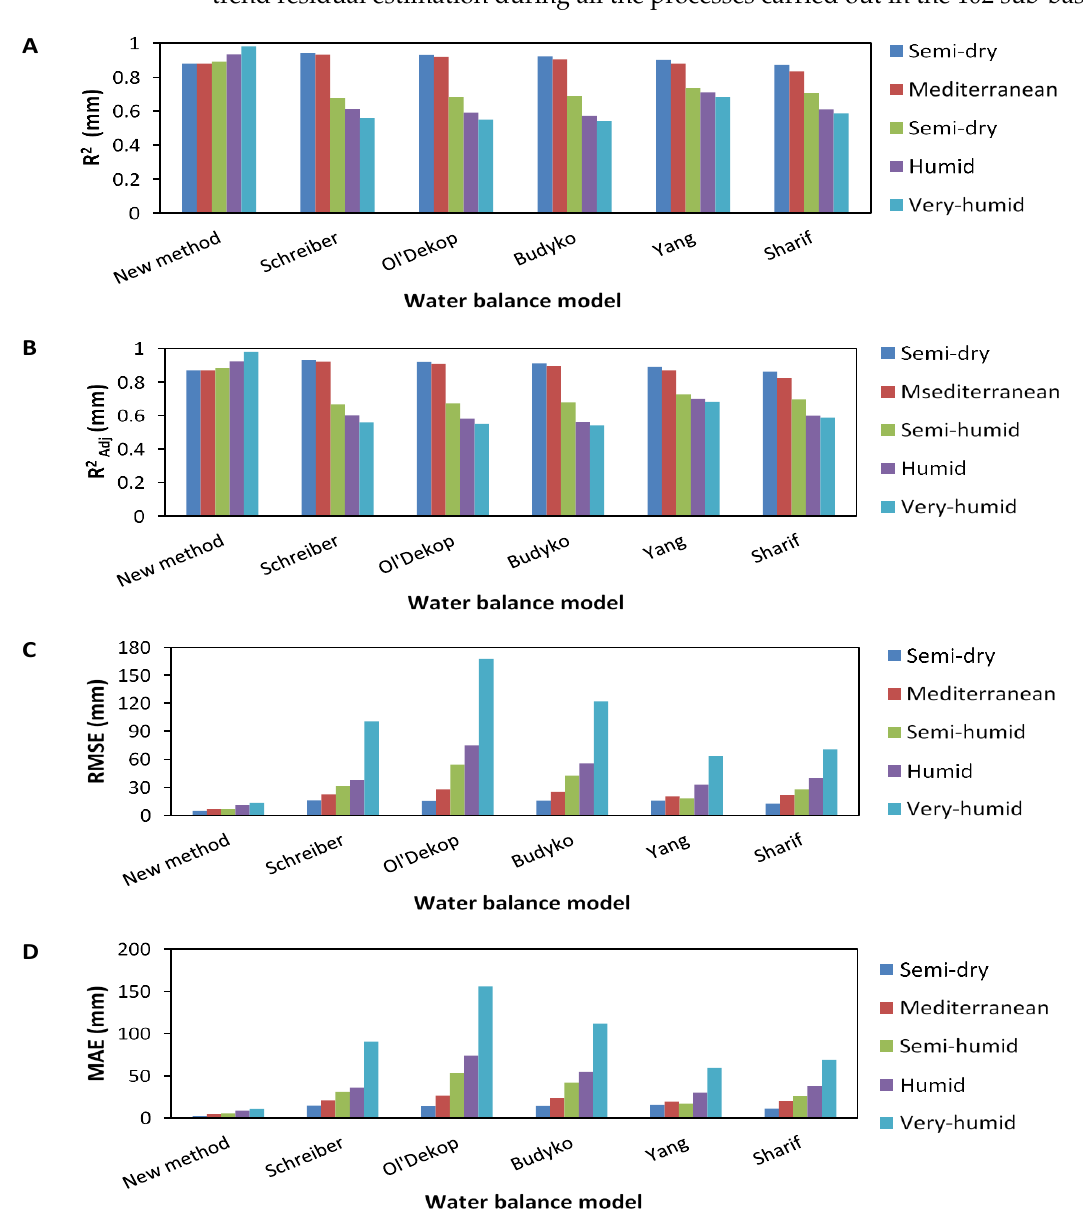
Figure 10. Histograms explaining performance analysis of the new model against a set of parametric (Yang, and Sharif) and non-parametric (Schreiber, Ol’Dekop, and Budyko) water balance models on five climatic regions of Northern Algeria. These were shown by ( A ) determination coefficient (R 2 ); ( B ) adjusted coefficient of determination (R 2Adj ); ( C ) root mean square error (RMSE); ( D ) mean absolute error (MAE).